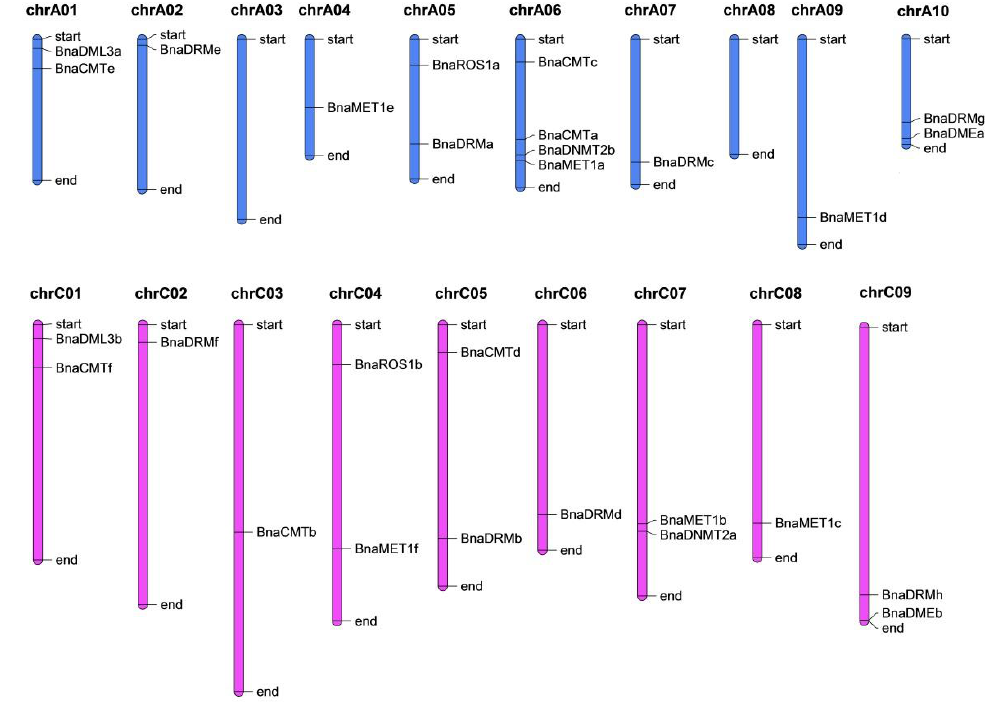
Figure 1. Evolutionary relationship, gene structure, and protein domain analysis of rapeseed DNA-MTase and DNA-deMTase gene families.